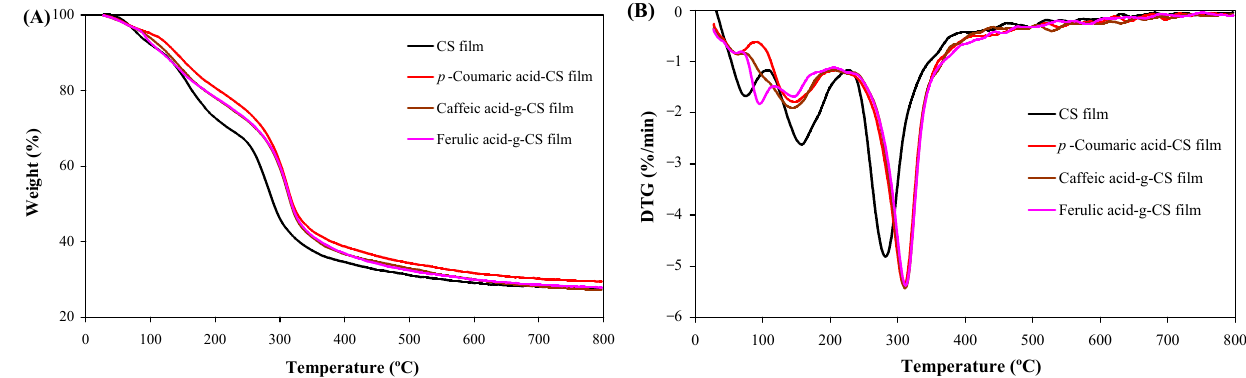
Figure 4. Thermogravimetric analysis (TGA) ( A ) and derivative TGA (DTG) ( B ) profiles of chitosan (CS) and different hydroxycinnamic acid-g-CS films.